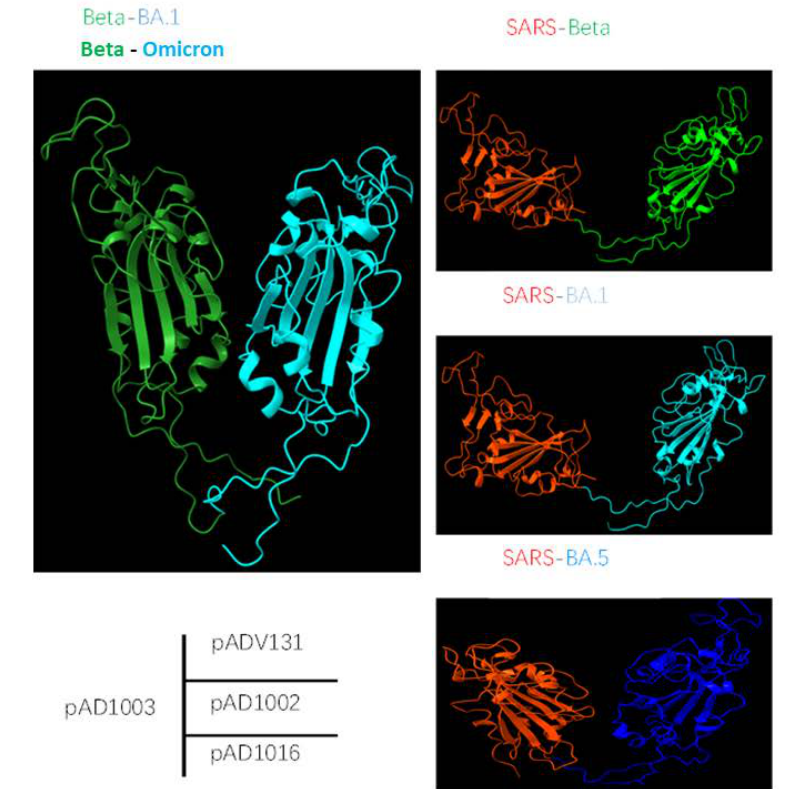
Figure 5. Comparison of AI-modeled molecular structure of the polypeptides encoded by pAD1002, pAD1003, pAD131 and pAD1016. Of the 4 fusion RBD heterodimers, RBD Beta/BA1 forms “bilateral lung” structure, indicating stable complexation between RBD BA1 and RBD Beta , while RBD SARS/Beta , RBD SARS/BA1 and RBD SARS/BA5 are all in free-moving conformation, suggesting a possibility that RBD SARS can barely complex with RBDs of SARS-CoV-2 variants under physiological